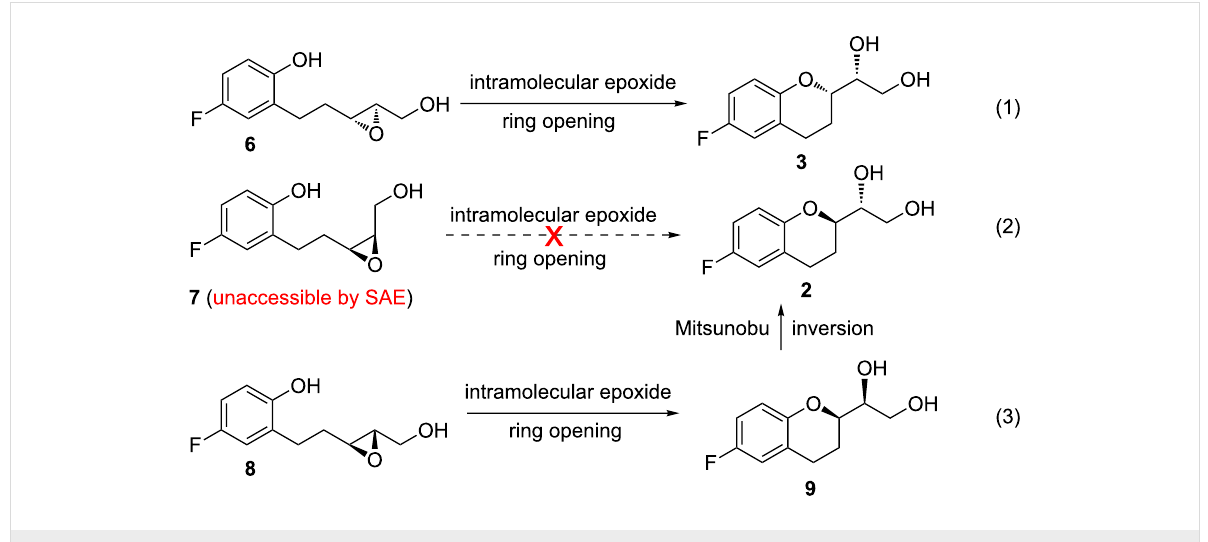
Scheme 1: Synthetic strategies toward late-stage intermediates of 1a .